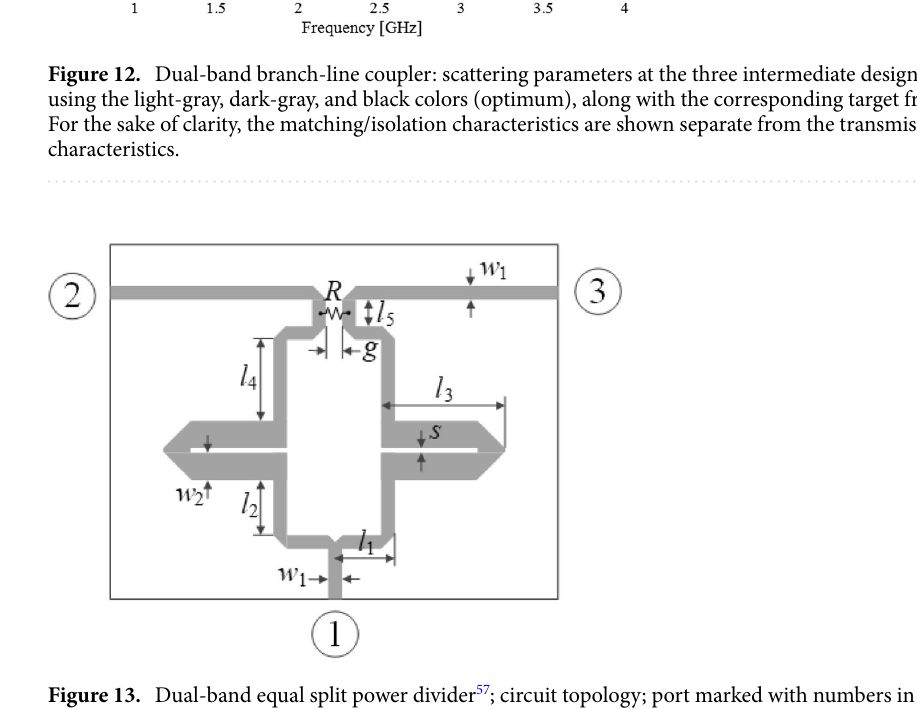
Figure 13. Dual-band equal split power divider 57 ; circuit topology; port marked with numbers in circles. Lumped resistor denoted as R .